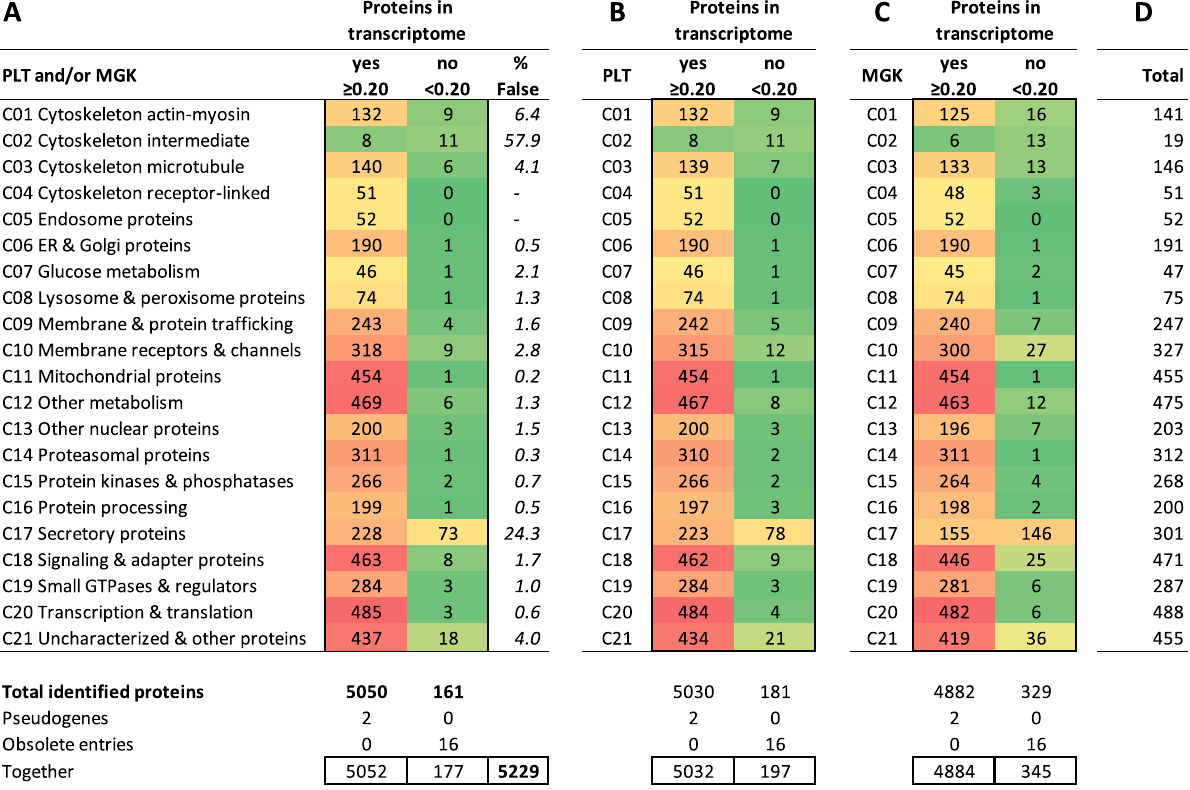
Table 2. Identified proteins in proteome in comparison to relevant transcriptome of platelets (PLT) and/or megakaryocytes (MGK). Indicated per function class are numbers of proteins with relevant (log2fpkm ≥ 0.20) or no relevant (log2fpkm < 0.20) mRNA expression. Analyzed were the combined PLT/MGK transcriptome ( A ), as well as the separate PLT ( B ) and MGK ( C ) transcriptomes. For the total of 5,232 identified proteins in the proteome, 2 appeared to be encoded by pseudogenes, and 16 were designated as obsolete entries in UniProt-KB. Also given are percentages of proteins without relevant expression level (% false). ( D ) Total numbers of assigned proteins per class independent of transcript